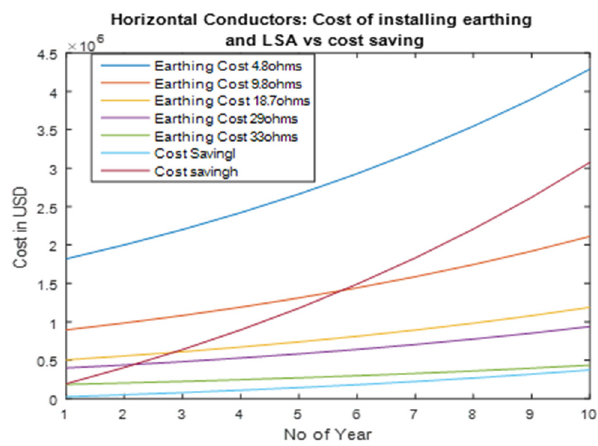
Figure 22. Break even cost of earthing enhancement with LSA vs. cost saving over a 10 years period.